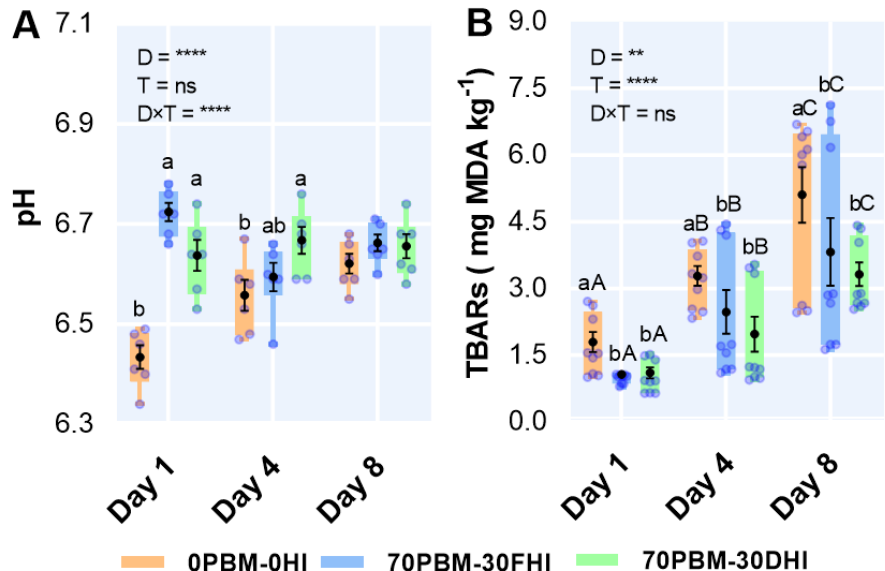
Figure 6. Changes in the fillet flesh pH ( A ) and TBARs ( B ) values after the 8-week feeding trial and at day 1, day 4, and day 8 when stored at 4 °C in barramundi fed complete replacement of fishmeal (FM) diets with mixtures of poultry by-product meal (PBM), full-fat Hermetia illucens (FHI), and partially defatted Hermetia illucens (DHI) larvae meal. Semi-transparent light blue round markers indicate individual datapoints ( n = 9), while the box–whisker plot of individual datapoints and black markers denote the mean and standard error values, respectively. Lower cases indicate significant differences between the treatments, while upper cases in the figure indicate significant differences between the storage days. Asterisks represent the significant differences at ** p < 0.01, and **** p < 0.0001 and ns denotes non-significant.